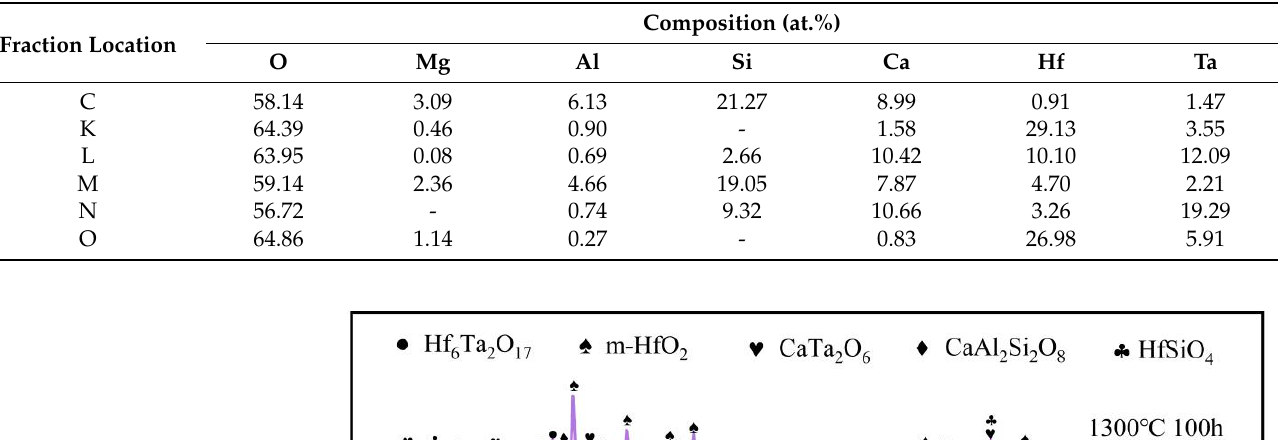
Table 4. Chemical compositions of the marked regions in Figure 11.